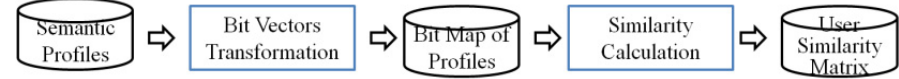
Fig. 3. Operation of construction of the user similarity matrix.